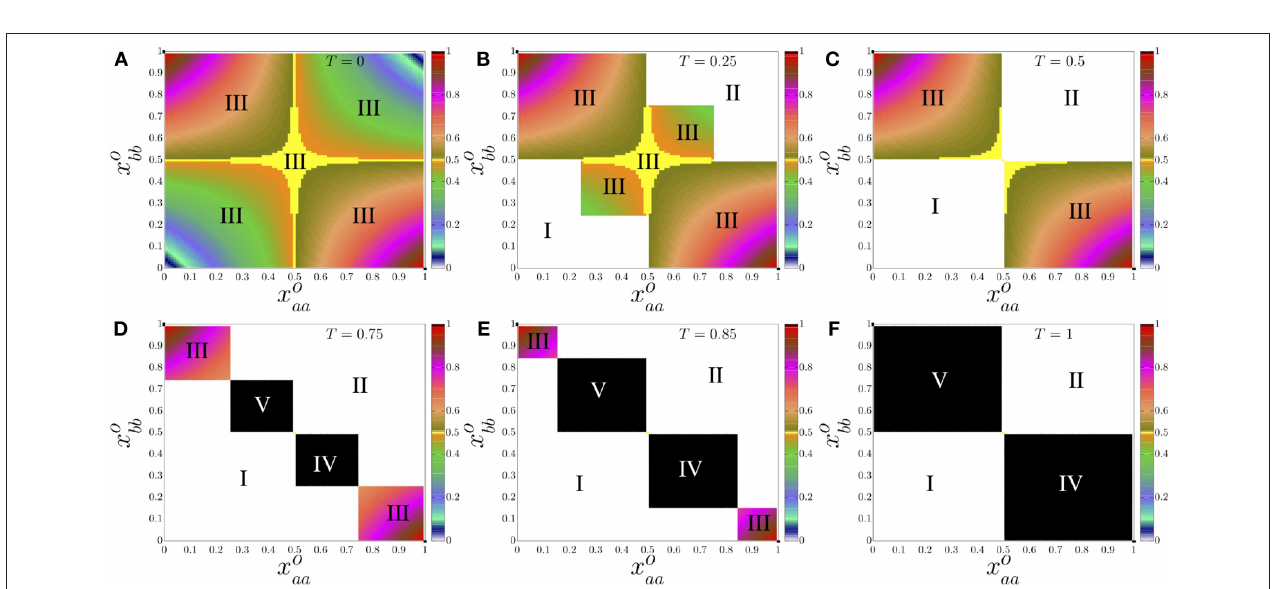
FIGURE 3 | Time evolution of x aa (circles), x bb (squares) and the density of active inter-layer links n AB (dashed lines). (A–D) Show the time evolution to coordination (solutions I and II) and anticoordination states (solutions IV and V) for symmetric game ( s = 0, b = 0) with T = 0.75. (E–G) Show the phase and anti-phase oscillations [solutions III (2)] of the fraction of strategies x aa and x bb for symmetric game ( s = 0, b = 0) with T = 0.25. (H–J) Show the temporal evolution of x aa and x bb and the active inter-layer links n AB , for the asymmetric coordination game ( s = 1, b = 0.5) with T = 0.25. (H,I) Show the chimera states, solution III-a and III-b respectively and (J) shows the case when the initial and the final states are the same when x aa = 0 and x bb = 0.5.